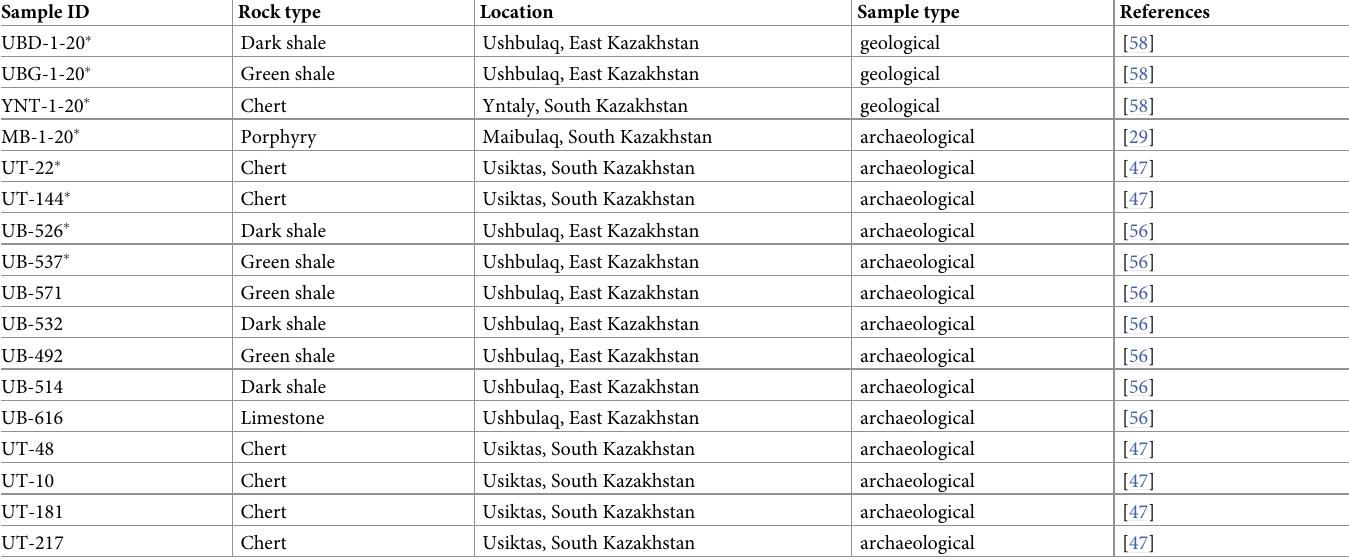
Table 1. Description of analysed